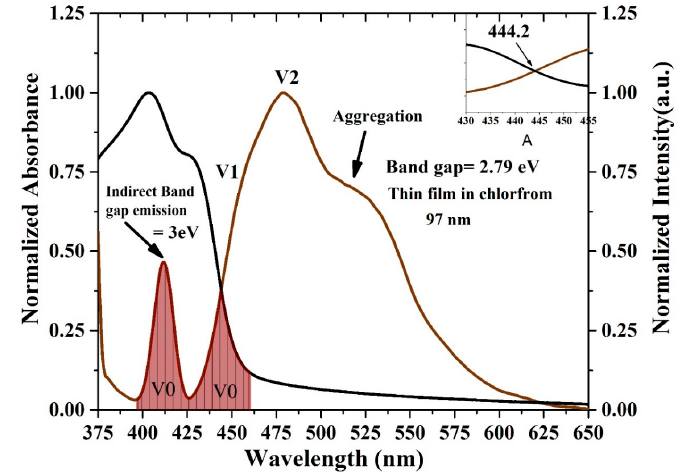
Figure 9. Optical energy gap by crossing the absorption and fluorescence spectra of the CO thin film. The black and brown curves are normalized absorption and fluorescence spectra, the area fill with brown color indicates the spectral overlap between the absorption and fluorescence spectra, attributed to V0 (0-0) band.